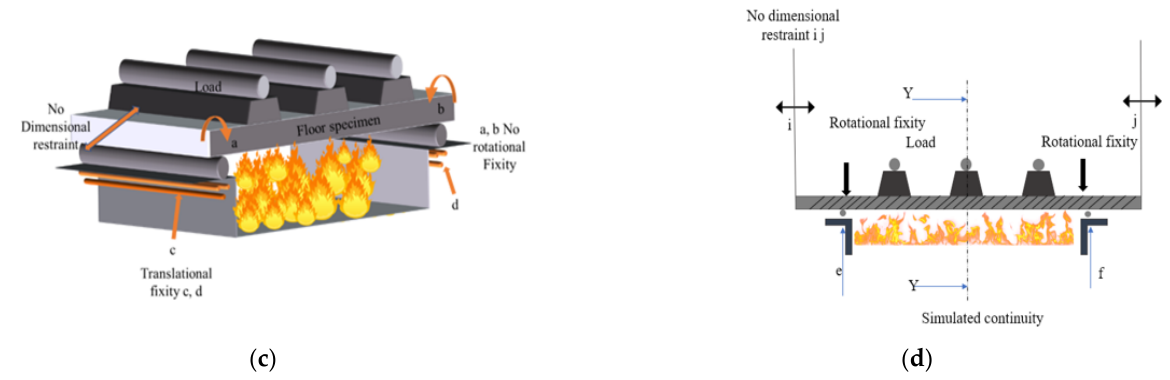
Figure 7. Restraints for floors: ( a ) 2D, ( b ) section, ( c ) 3D, and ( d ) rotational fixity.